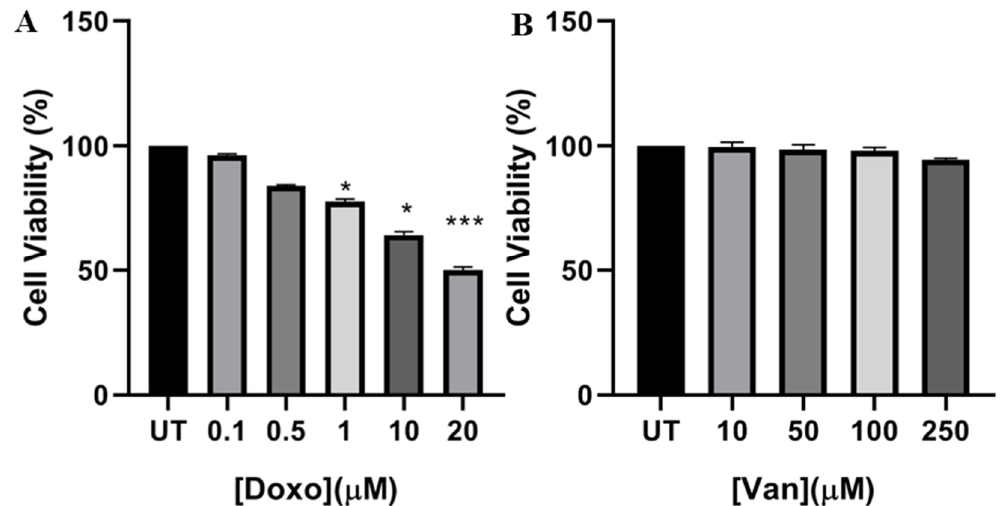
Figure 1. E ff ect of doxo and vanillin on cell viability. Cell viability was evaluated by MTT assay in H9c2 cells exposed for 24 h to ( A ) increasing concentration of doxo (from 0.1 to 20 µ M) and to ( B ) di ff erent concentrations of vanillin (20, 50, 100 and 150 µ M) UT—untreated cells. Data are expressed as average percentage of MTT reduction ± SD relative to untreated cells from triplicate wells from 5 separate experiments. *: p < 0.05; ***: p < 0.001 by unpaired t -test. Other experimental details are described in Materials and Methods section.